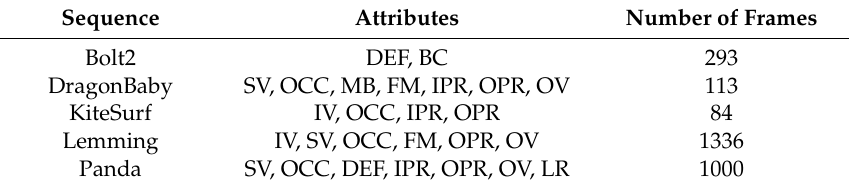
Table 8. Attributes of test video sequences on